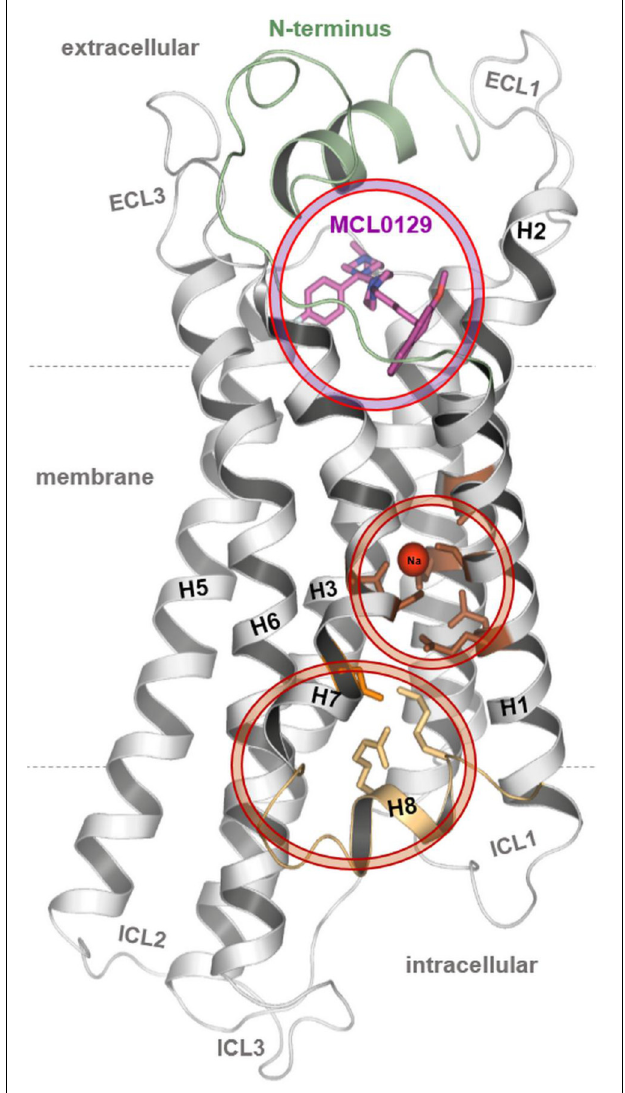
FIGURE 1 | The final conformation of the hMC4R model with docked MCL0129, sodium binding and an unusual organization for the distal end of helices